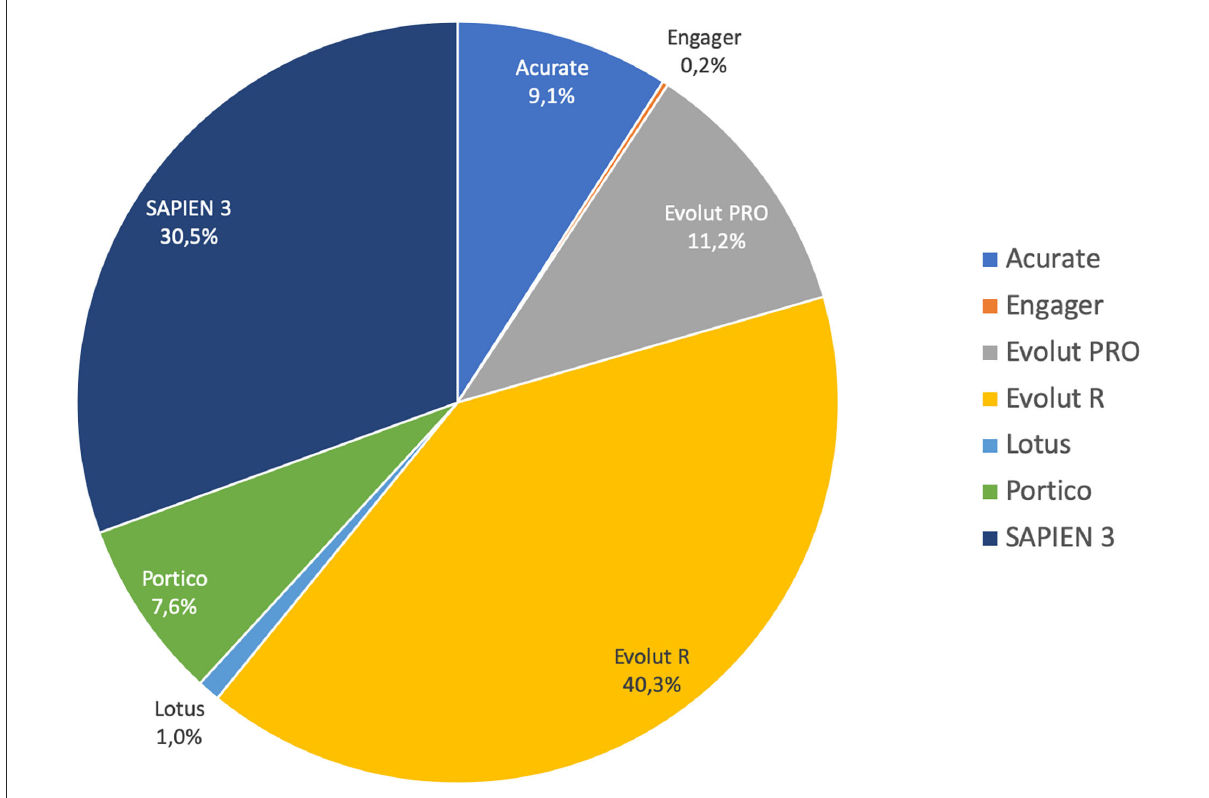
FIGURE2 Pie chart showing the proportion of different devices